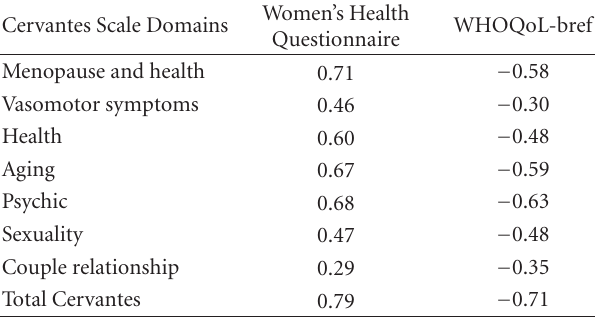
Table 3: Correlation between the domains and subdomains of the brazilian portuguese versions of the cervantes scale, women’s health questionnaire and the